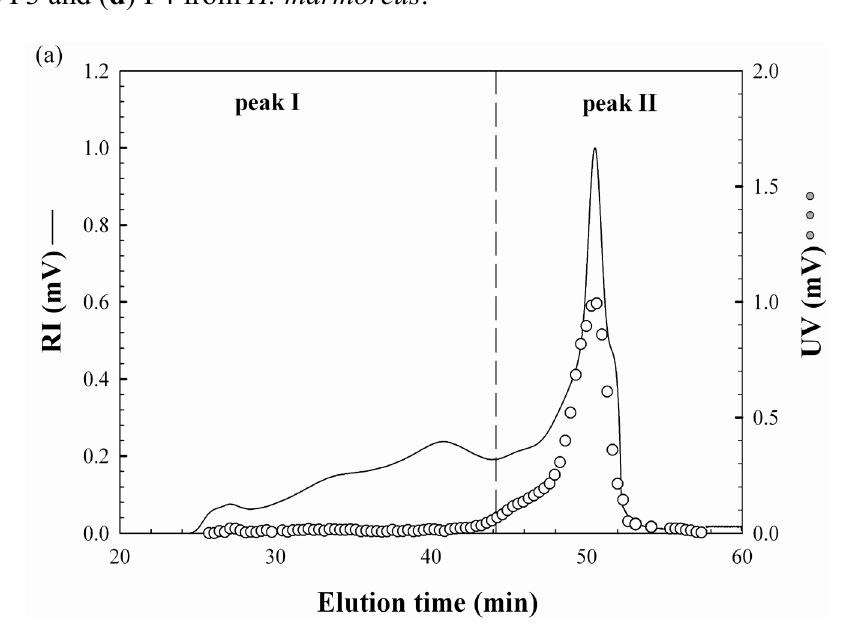
Figure 1. RI and UV chromatograms of the water-unextractable proteoglycans ( a ) F1, ( b ) F2, ( c ) F3 and ( d ) F4 from H. marmoreus